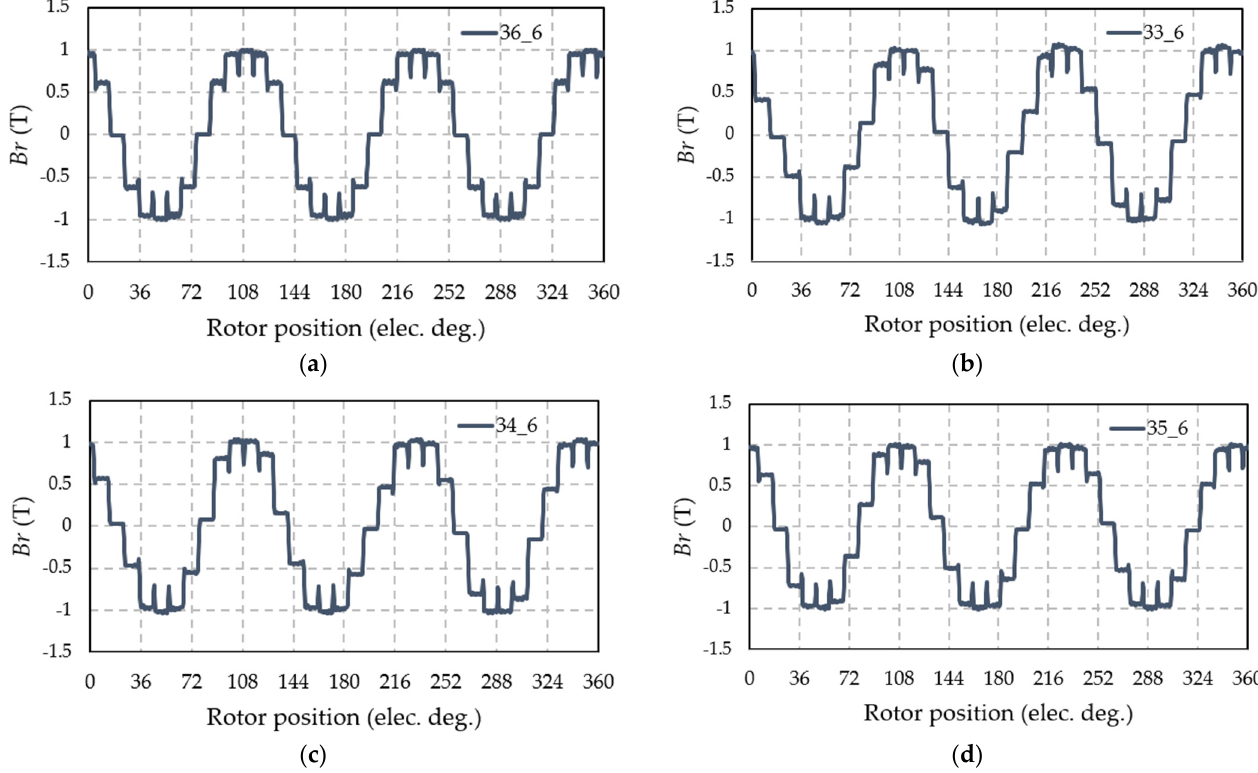
Figure 5. Air − gap flux density waveforms of four motors without flux barrier: ( a ) M 1 : 36 − slot and 6 − pole; ( b ) M 2 : 33 − slot and 6 − pole; ( c ) M 3 : 34 − slot and 6 − pole; ( d ) M 4 : 35 − slot and 6 − pole.